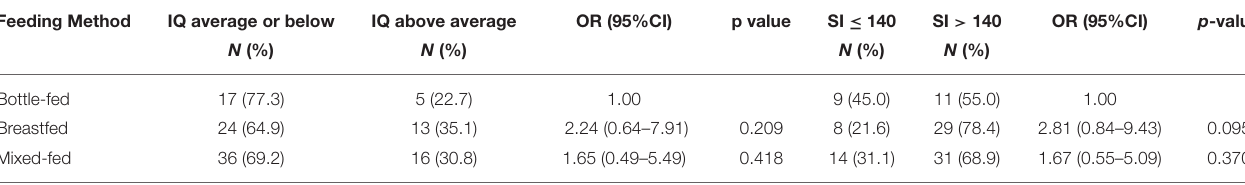
TABLE 3 | Association between feeding method and IQ or SI using logistic regression analysis. Feeding